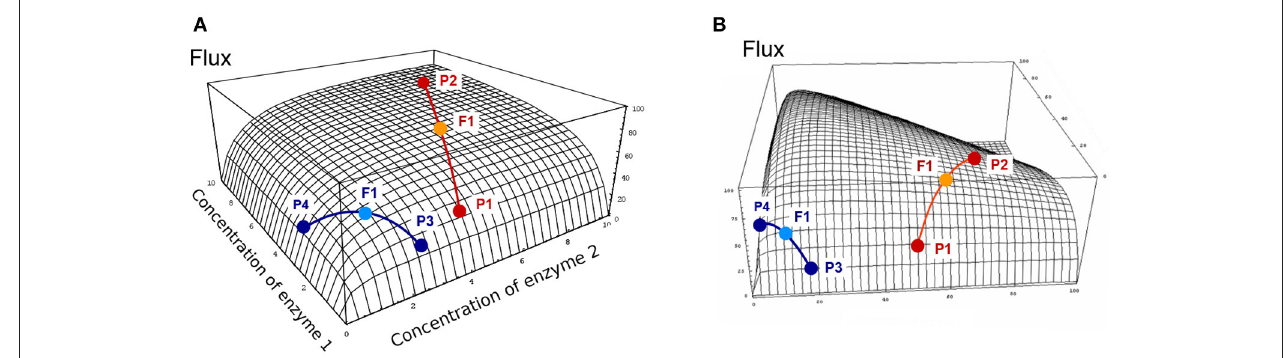
FIGURE 4 | Flux response upon variation of two enzymes in a hyperbolic GP relationship. The two enzymes have the same arbitrary values of their kinetic parameters. Red and blue curves show two types of crosses between parents P1 and P2, or P3 and P4, respectively (from Fiévet et al., 2010). The positions of hybrids F1 (light blue and orange points) were determined assuming additivity of enzyme concentrations. (A) In the “red” cross, where parent P2 has a flux close to the maximum (high concentration of both enzymes), there is positive mid-parent heterosis (+MPH) for the flux. In the “blue” cross, where parents have low flux values due to low concentrations of enzyme 1 (parent P3) or enzyme 2 (parent P4), the hybrid displays best-parent heterosis (BPH). (B) If there is a constraint on the total enzyme amount, the “red” cross also displays BPH because the concavity of the surface is